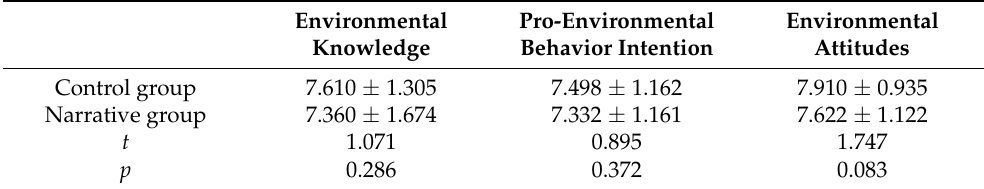
Table 5. The results of independent samples t-test of children’s environmental awareness in the experimental group and the control group.